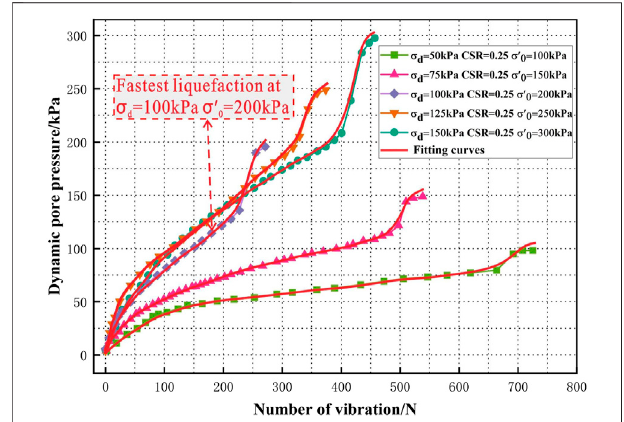
FIGURE 6 | Development curves of accumulated pore pressure under unidirectional vibrations with the same CSR conditions.